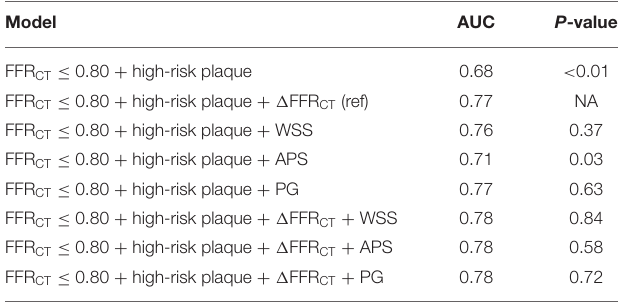
TABLE 4 | 1 FFR CT as a representative marker of local hemodynamic parameters in prediction of culprit lesions causing acute coronary syndrome.